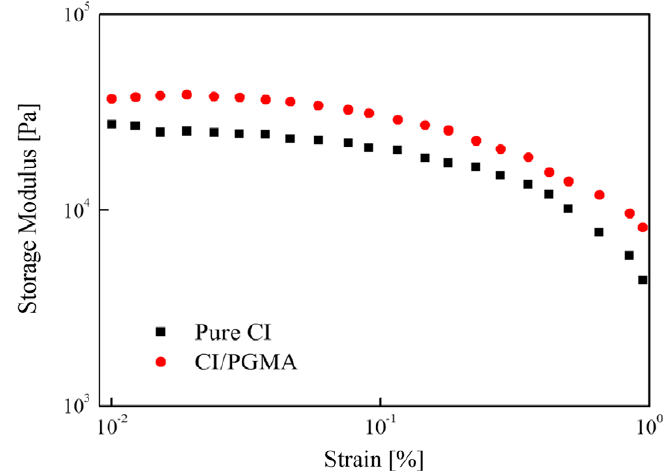
Figure 4. The storage moduli CI/PGMA and pure CI based magnetorheological (MR) elastomers [60].